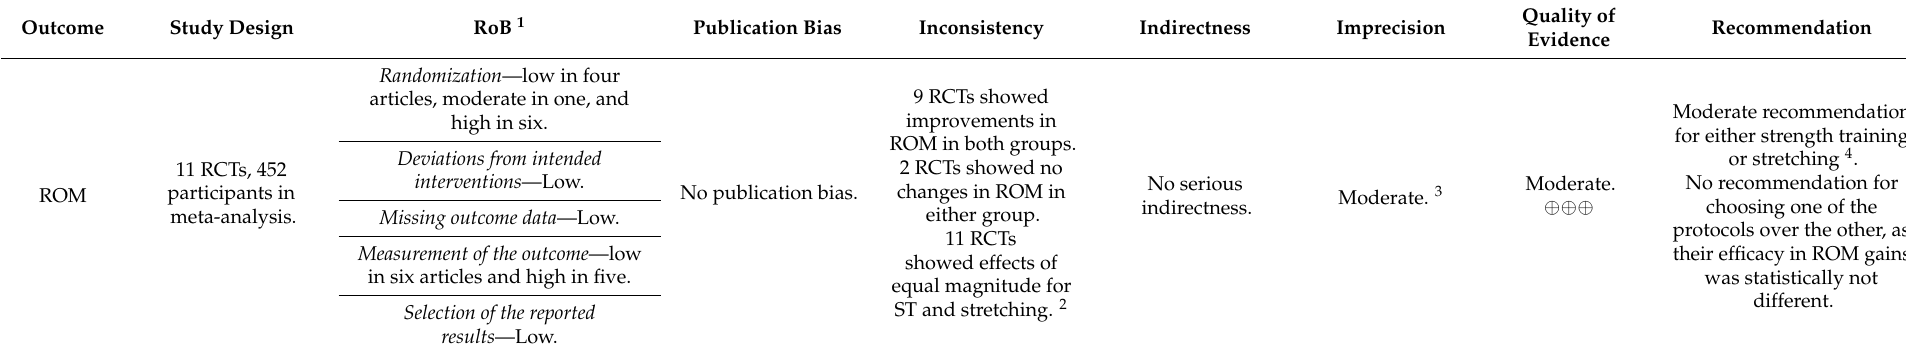
Table 3. GRADE assessments for the certainty of